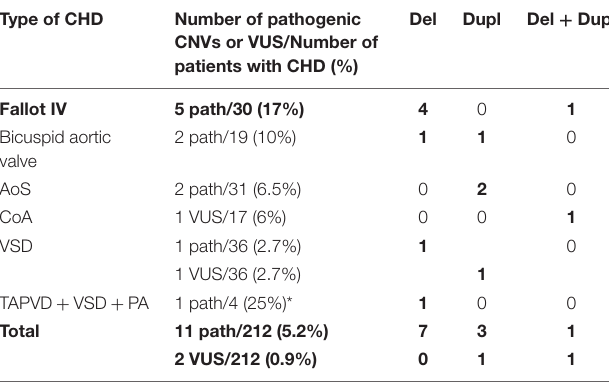
TABLE 2 | The distribution of the pathogenic and VUS 22q11 CNVs in the different CHD groups. Type of CHD Number of pathogenic CNVs or VUS/Number